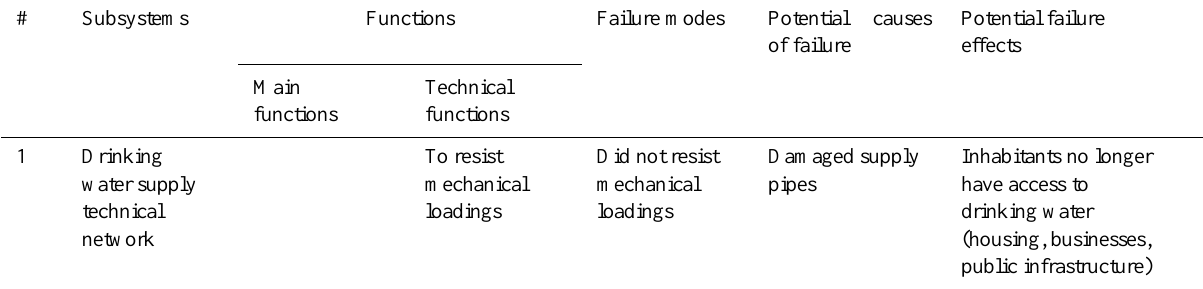
Table 3. Sample FMEA applied to drinking water supply technical